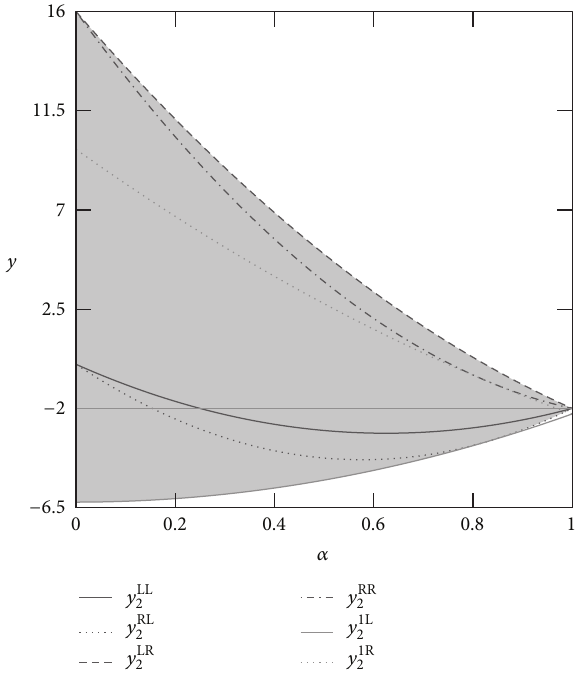
Figure 2: Solution candidates from Example 2.